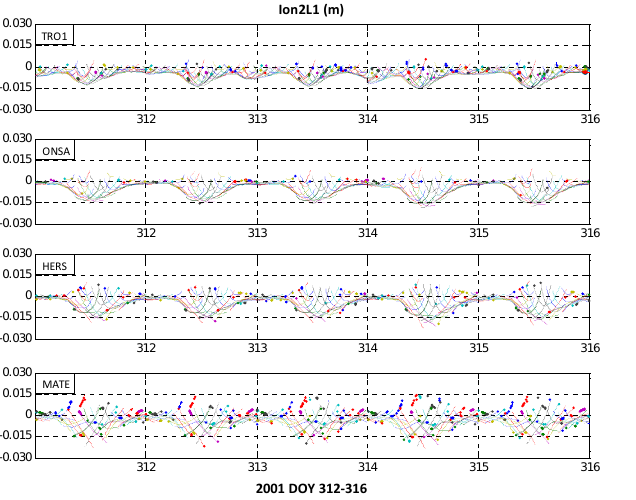
Fig. 3. Ion2 (m) for GPS L1 (Ion2L1) for the observation stations on DOY 312‐316 in 2001.